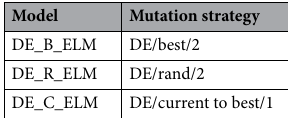
Table 8. Settings of the single-strategy models.